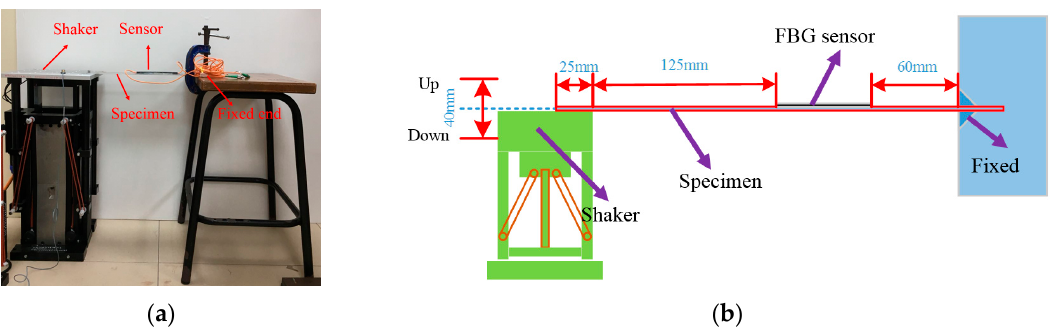
Figure 8. ( a ) Experimental setup of dynamic tests; ( b ) Schematic diagram of experimental setup.